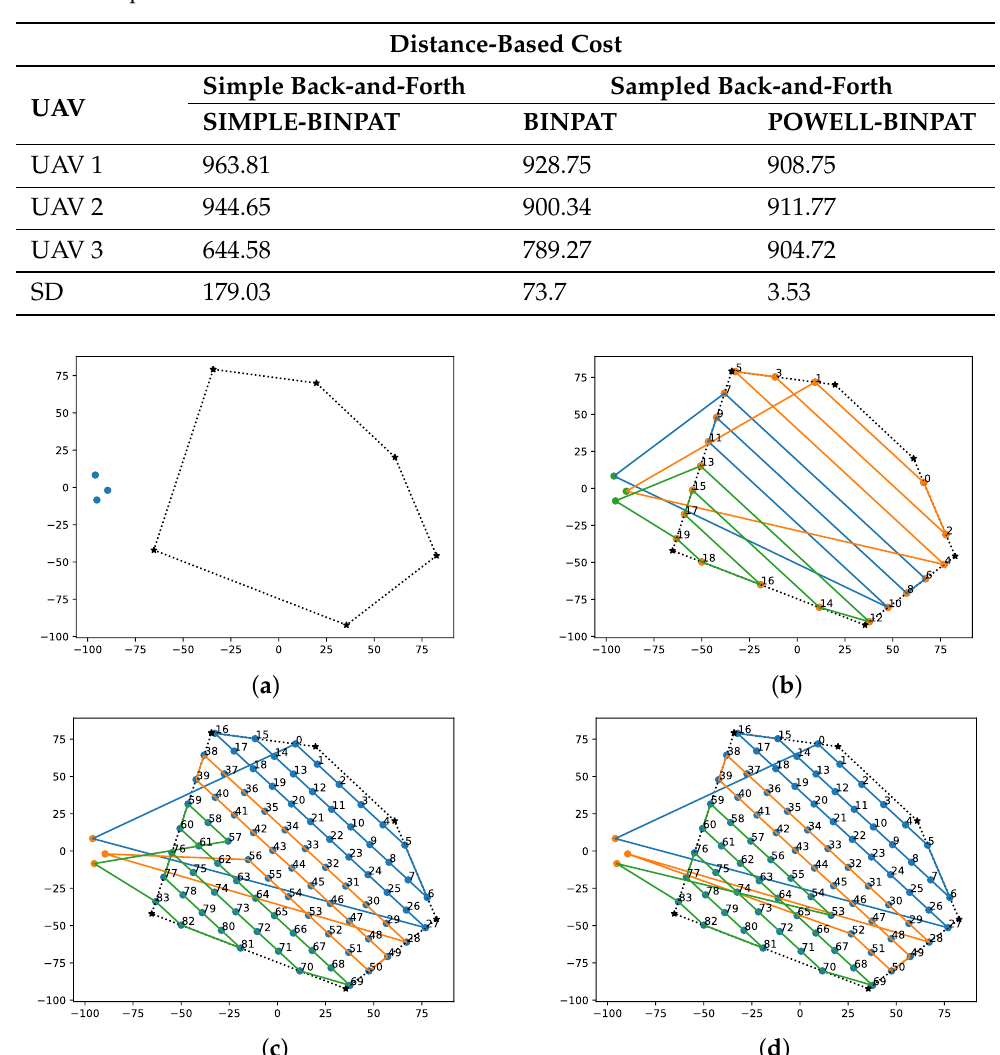
Figure 8. Multi-UAV algorithm results: ( a ) defined search area and UAV locations; ( b ) SIMPLE-BINPAT; ( c ) BINPAT; and ( d ) POWELL-BINPAT